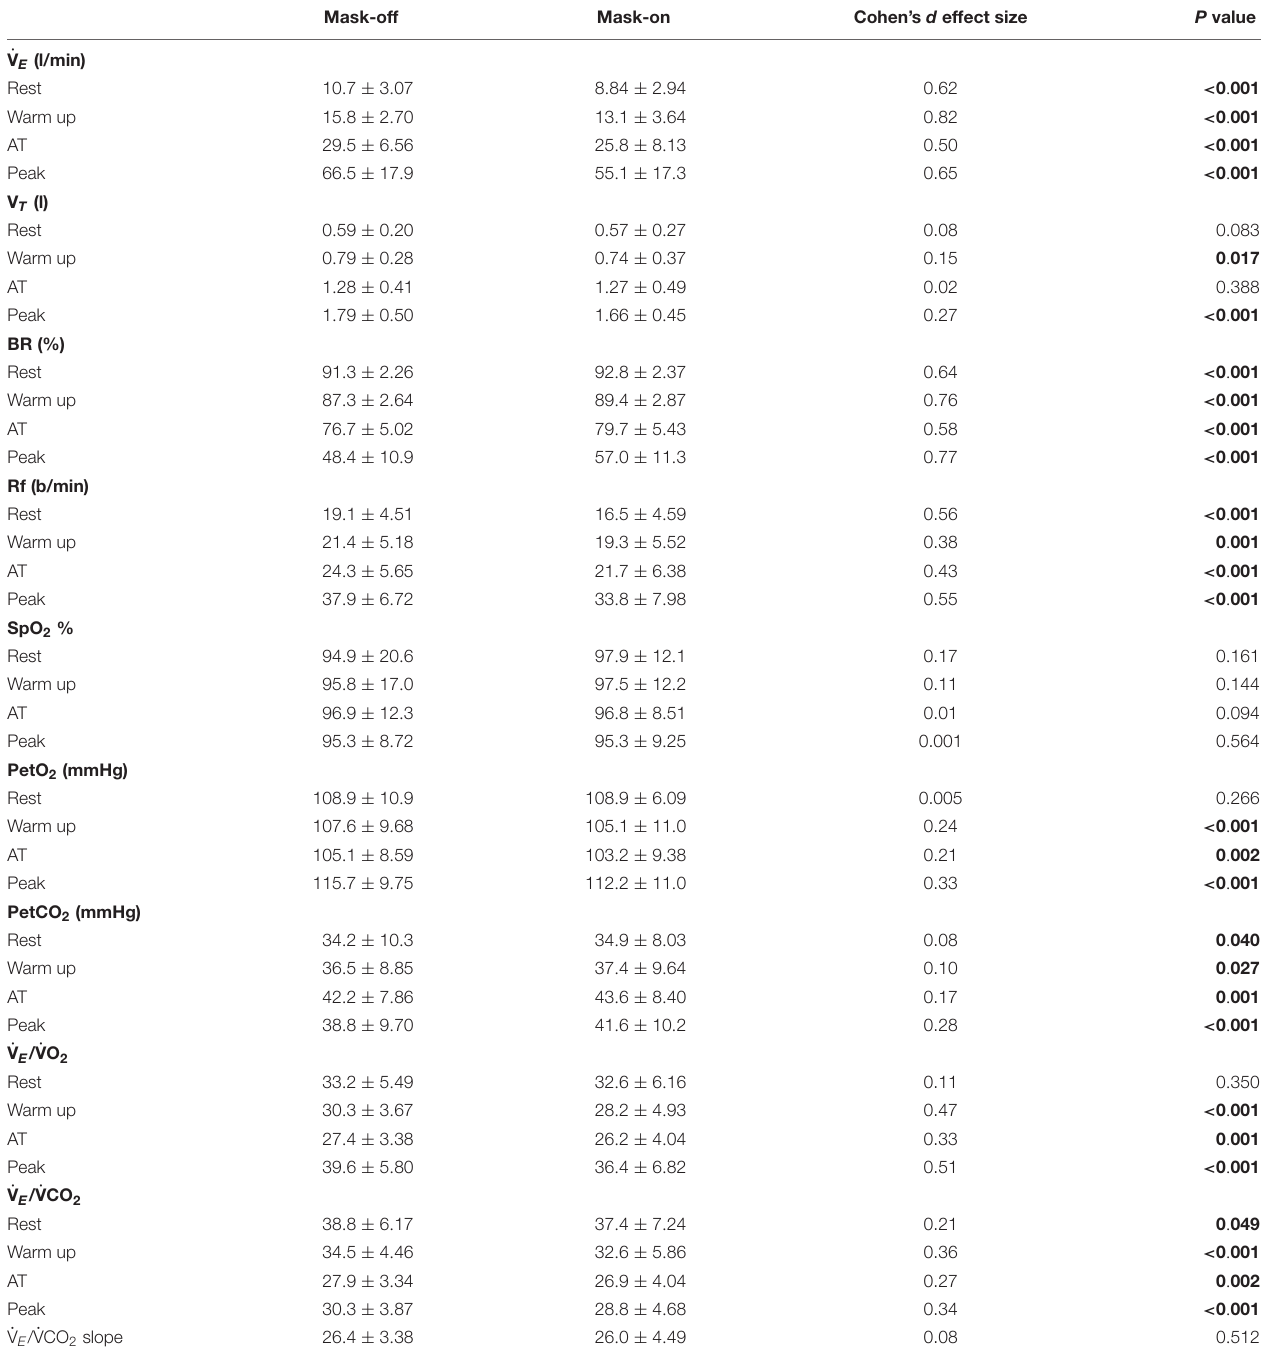
TABLE 4 | The comparison of pulmonary ventilation parameters between mask-on and mask-off condition. Mask-off Mask-on Cohen’s d effect size P